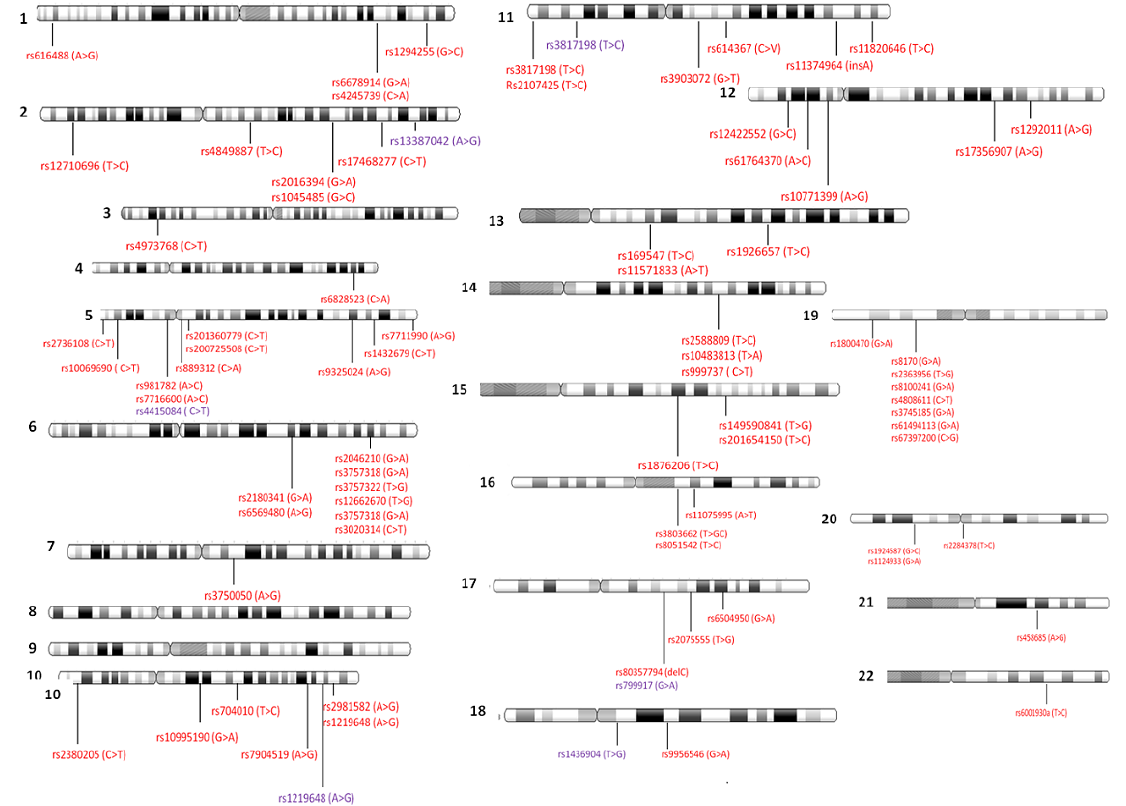
Figure 5. Locations of TNBC-related SNPs distributed across all somatic human chromosomes. In red color, SNPs related to TNBC risk, and in violet color, SNPs associated with different outcomes of TNBC (taken from Table S1). Abbreviations: A, adenine; C, cytosine; T, thymine; G, guanine.